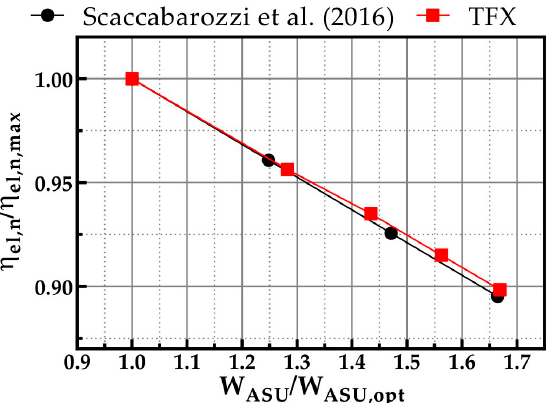
Figure 9. Net electric efficiency of the Allam cycle as a function of ASU-specific work. Validation